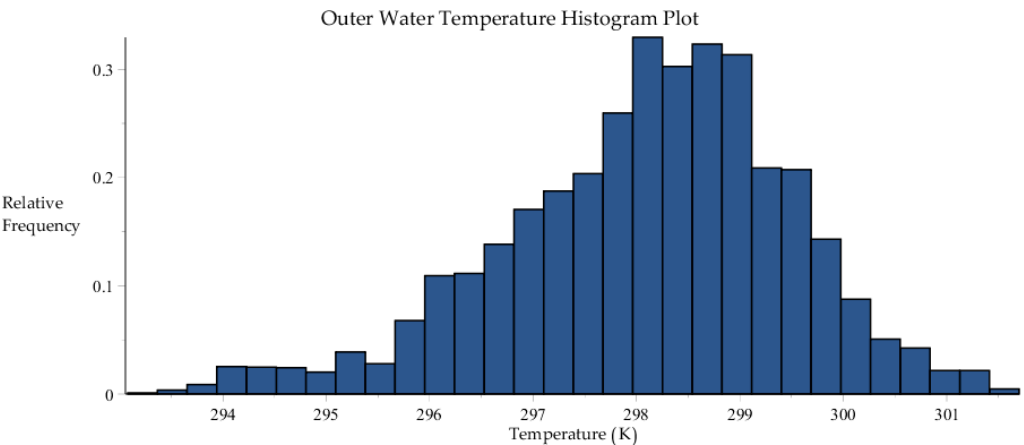
Figure A5. Histogram plot of water outlet temperature measurements, within the 7688 data sets collected by SRNL from F-Area cooling towers.